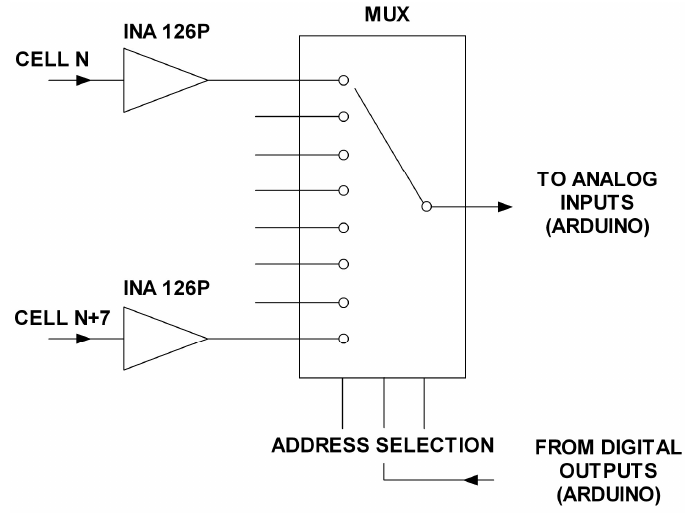
Figure 2. AMB schematic diagram.